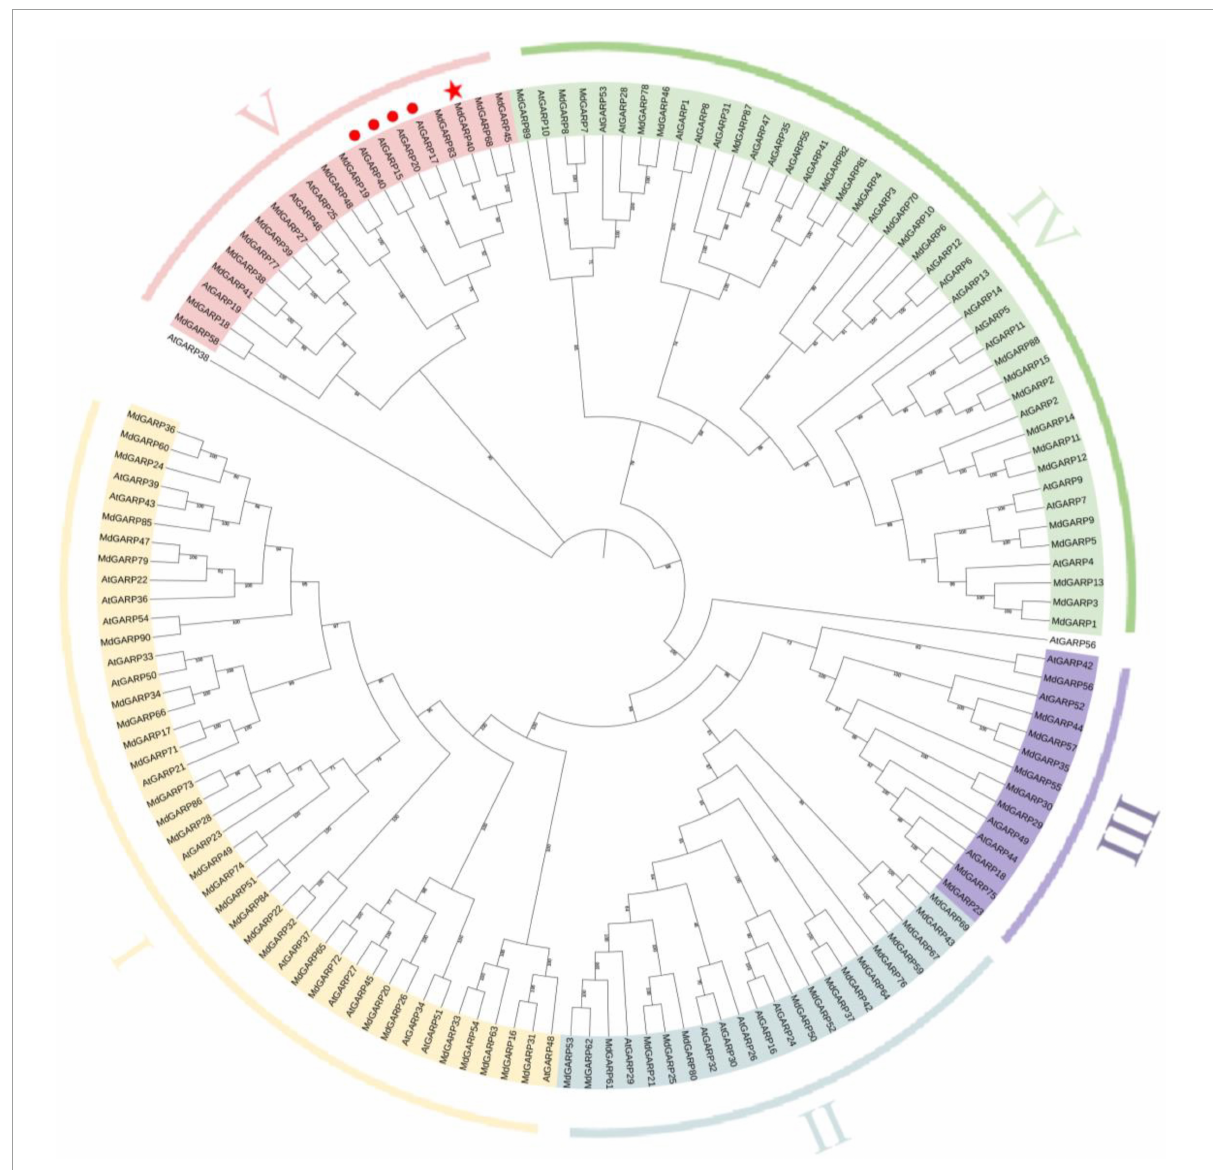
FIGURE1 Phylogenetic tree of GARP-type proteins from apple and Arabidopsis . The phylogenetic tree was constructed using the NJ (neighbor-joining) algorithm. GARP proteins were clustered into five classes, and the five subfamilies are distinguished by different colors. The confirmed GARP-type protein sequences from apple and Arabidopsis were used to construct a phylogenetic tree using the MEGA software with the NJ method, a bootstrap value of 1,000, and other default parameters. The red star indicates MdHHO3(MdGARP40). The red circles indicate Arabidopsis four NIGT1s (NIGT1.1-1.4), among which AtGARP17, AtGARP20, AtGARP40, and AtGARP15 indicate AtHHO3/AtNIGT1.1, AtHHO2/AtNIGT1.2, AtHHO1/AtNIGT1.3, and AtHRS1/AtNIGT1.4, respectively. The protein sequences are listed in Supplementary Table 1